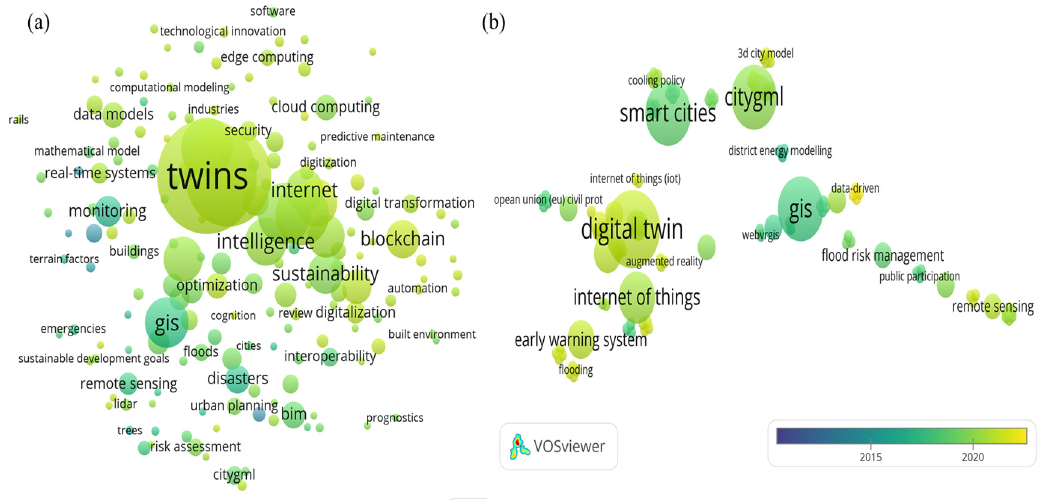
Figure 3. Keyword density visualisation with a time frame ( a ) first screening ( b ) second screening.